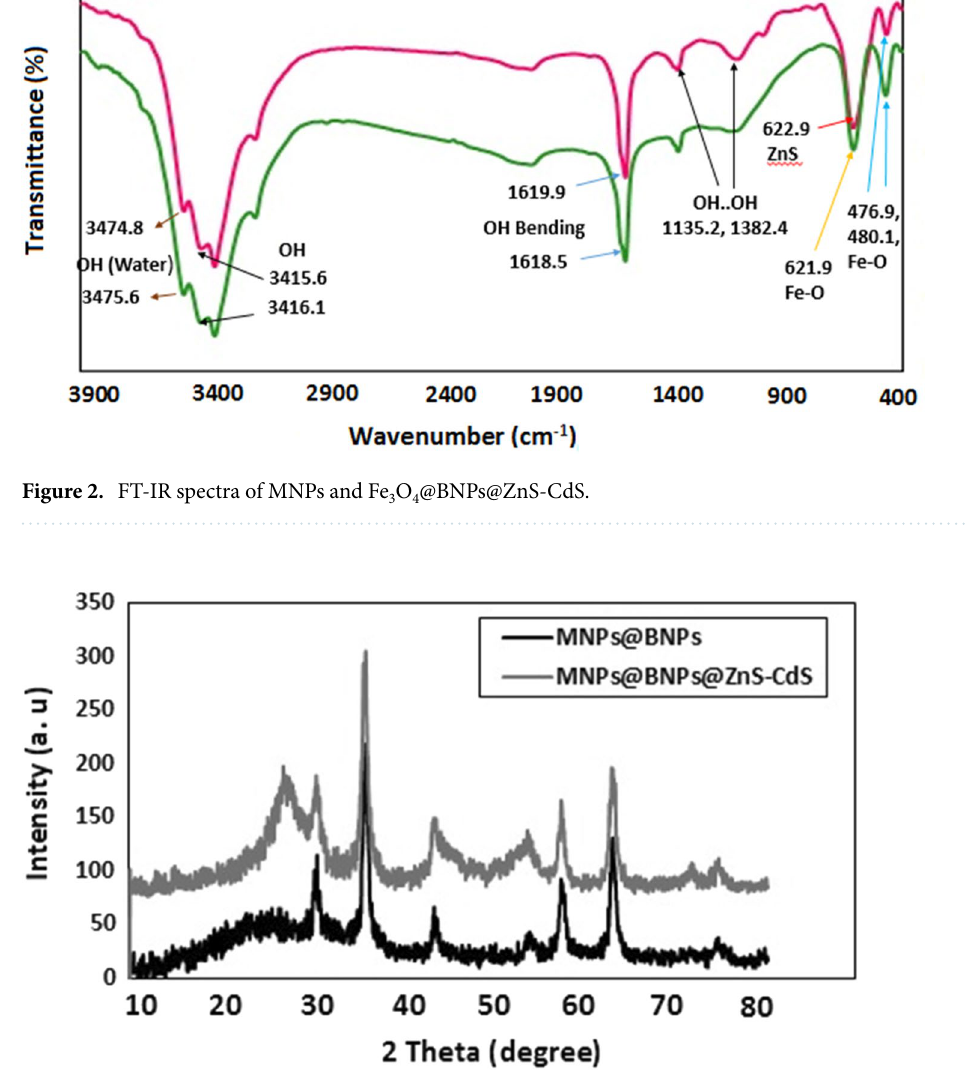
Figure 3. XRD diagrams of Fe 3 O 4 @BNPs and Fe 3 O 4